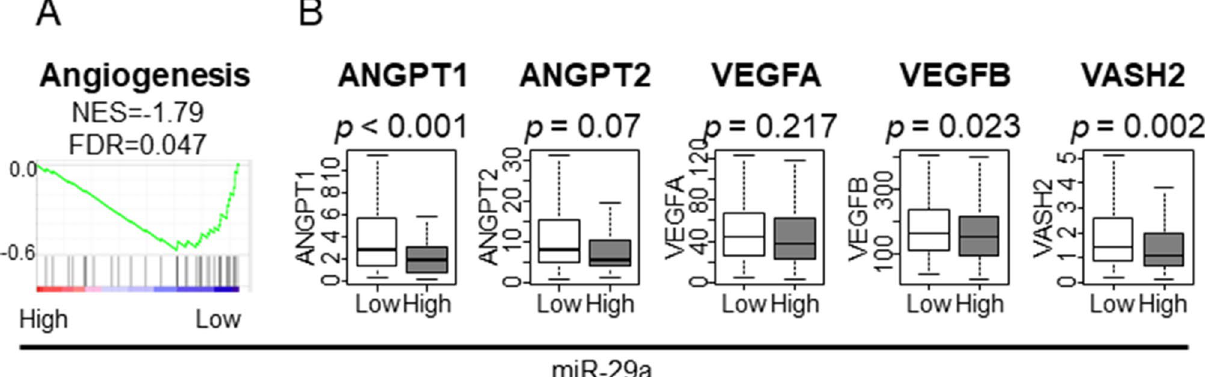
Figure 3. GSEA of angiogenesis-related gene sets and the association between miR-29a and angiogenesis -related genes in TCGA STAD cohort. ( A ) GSEA of cell angiogenesis-related gene sets. ( B ) The association between miR-29a and angiogenesis-promoting genes. ANGPT1/2 Angiopoietin 1/2, VASH2 vasohibin 2, VEGF1/2 vascular endothelial growth factor1/2, NES normalized enrichment score, FDR false discovery rate. The statistical significance was defined by p < 0.05 or FDR < 0.25. Tukey-type boxplots demonstrate median and inter-quartile level values.